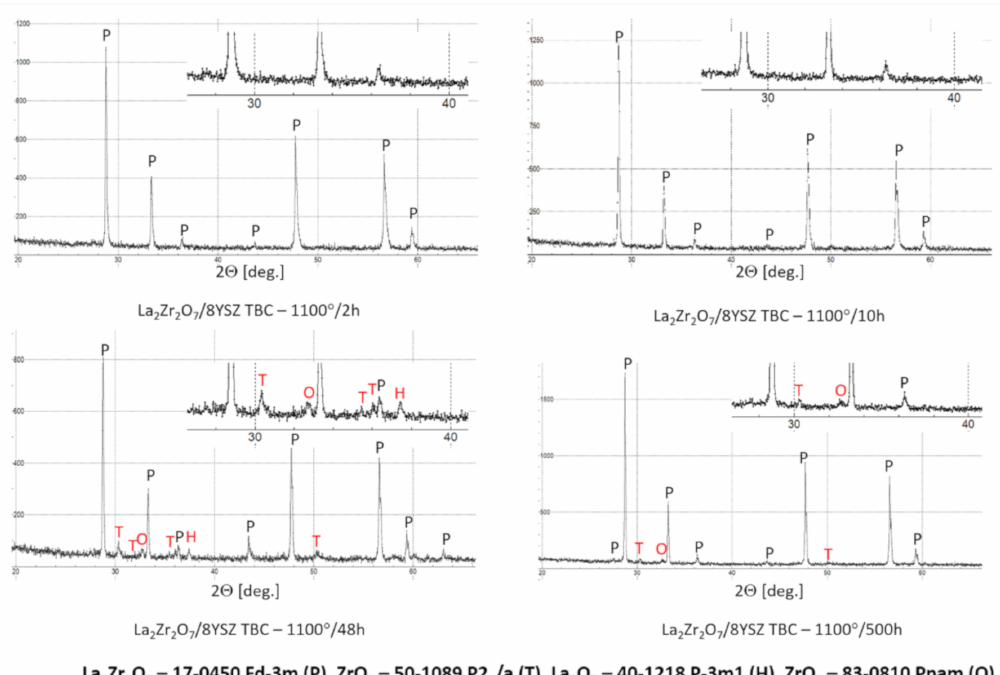
Figure 29. Phase composition of the ceramic top-coat of DCL La 2 Zr 2 O 7 / 50% La 2 Zr 2 O 7 + 50% 8YSZ / 8YSZ TBC after oxidation test at 1100 ◦ C with 500 h of exposure.